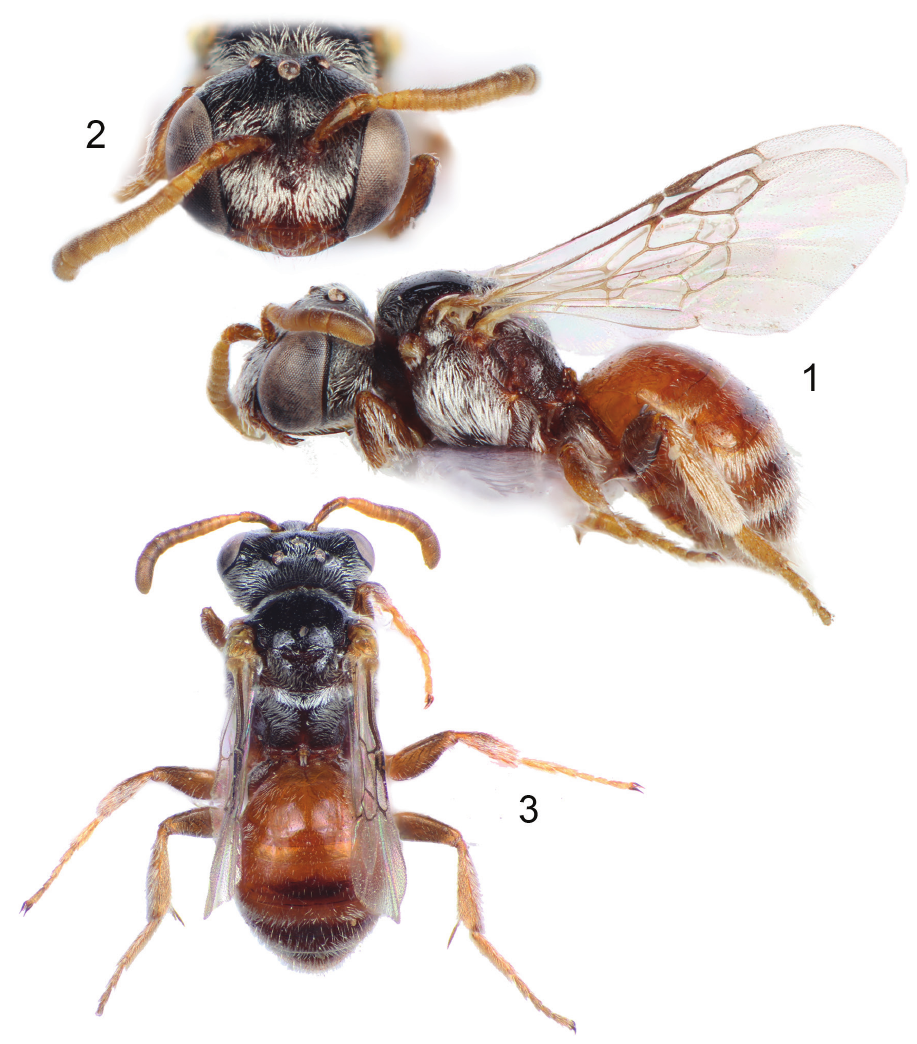
Figures 1–3. Female of Chiasmognathus nearchus Engel from Amariah, Saudi Arabia. 1 Lateral habitus 2 Facial view 3 Dorsal